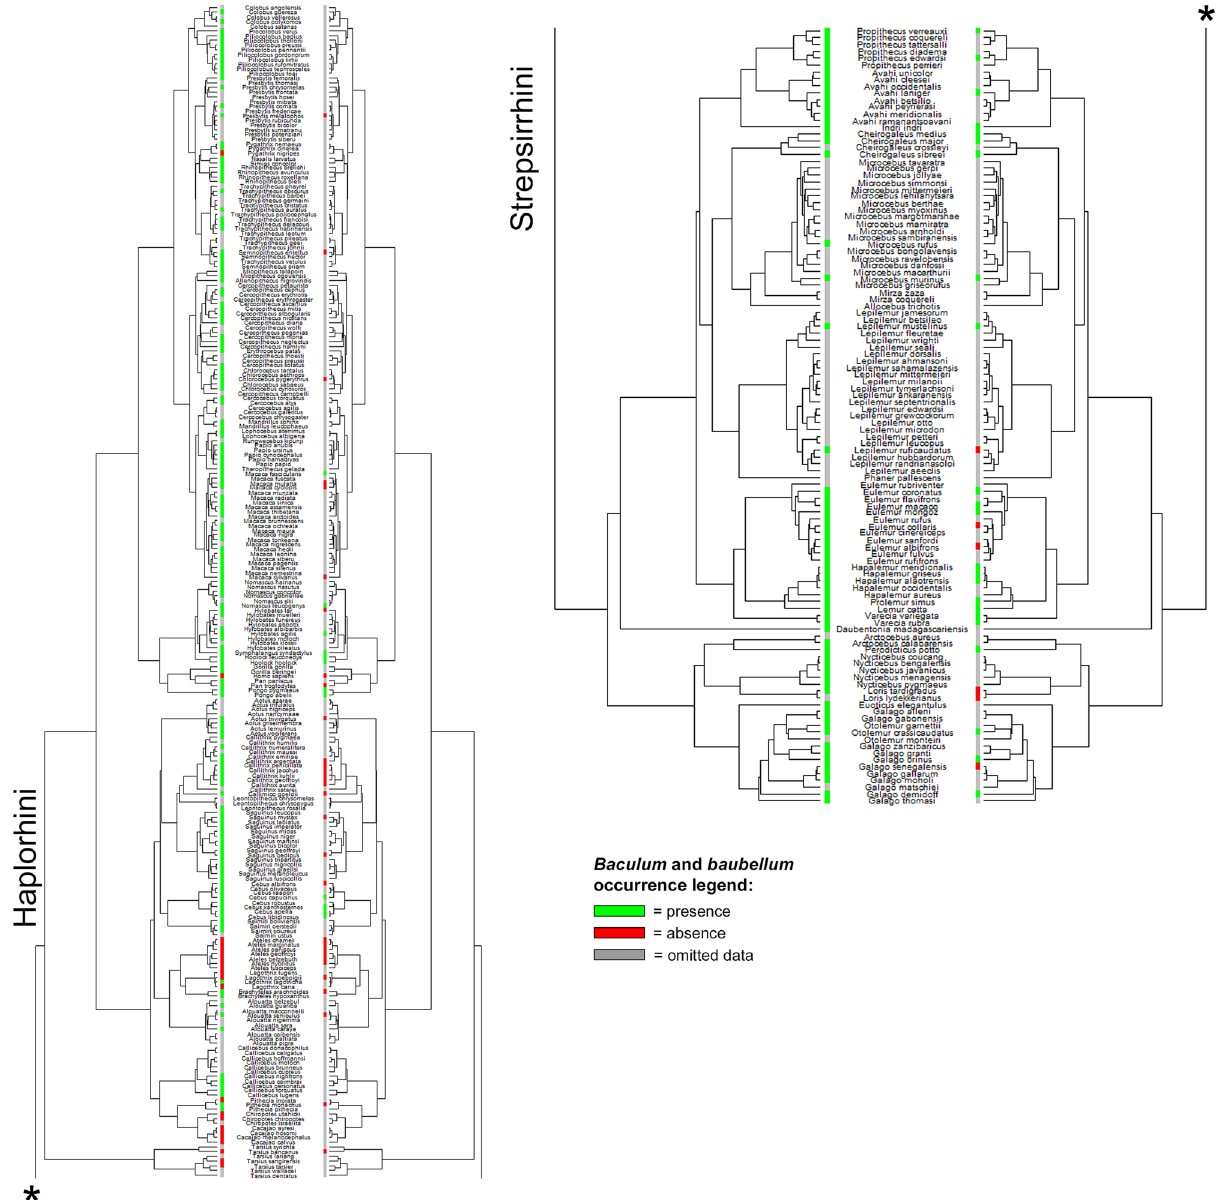
Figure 1. State of the knowledge of baculum and baubellum occurrence. Comparison between our baculum (left) and baubellum (right) occurrence data coverage of primate phylogeny. Green lines indicate the presence of ossa genitalia . Red lines indicate the absence of ossa genitalia . Grey lines stand for ‘omitted data’ (i.e., all those species for which neither absence nor presence of genital bones was ever stated). Phylogeny by Springer 71 , dropped. Figure generated in R (v. 4.0.3, https:// www.R- proje ct. org/) 114